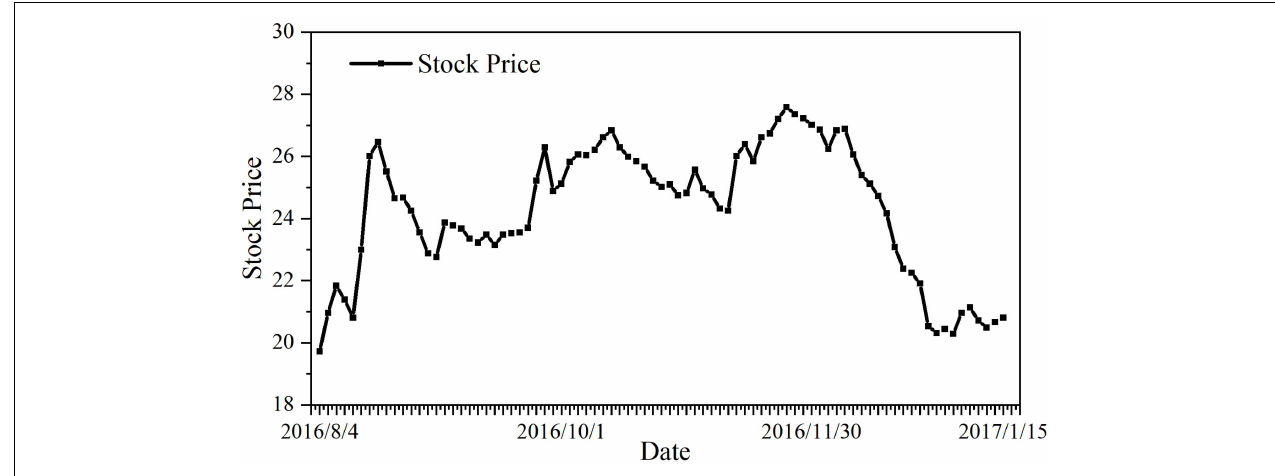
FIGURE 4 | Vanke’s stock price chart after Evergrande raised the placard. Data source: http://stock.hexun.com/2016-08-04/185332058.html.